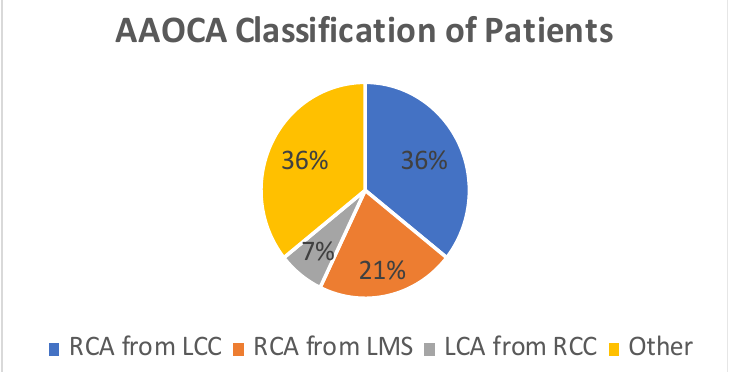
Figure 2. Pie Chart showing coronary artery morphology among patients. AAOCA — Anomalous aortic origin of coronary artery, RCA — right coronary artery, LCC — left coronary cusp, LMS — left main stem, LCA — left coronary artery, RCC — right coronary cusp.